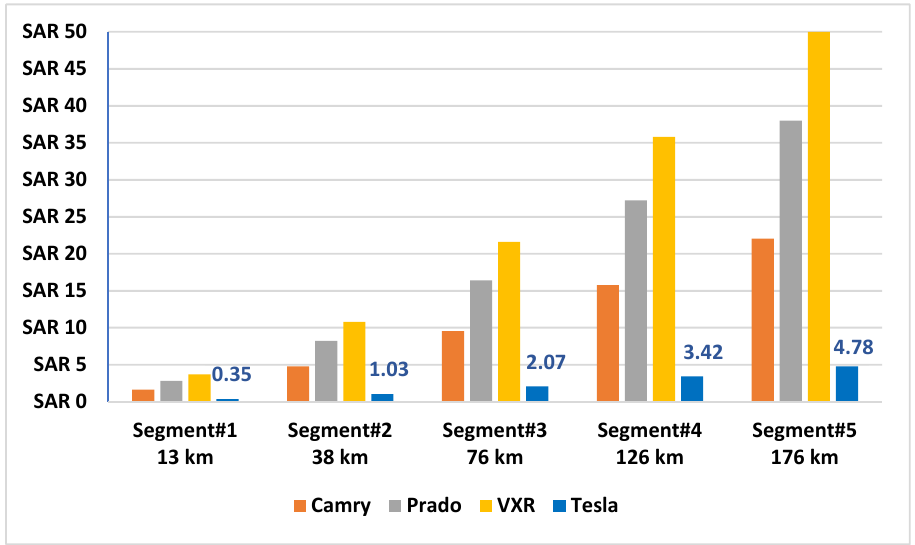
Figure 3. Fuel consumption per day.